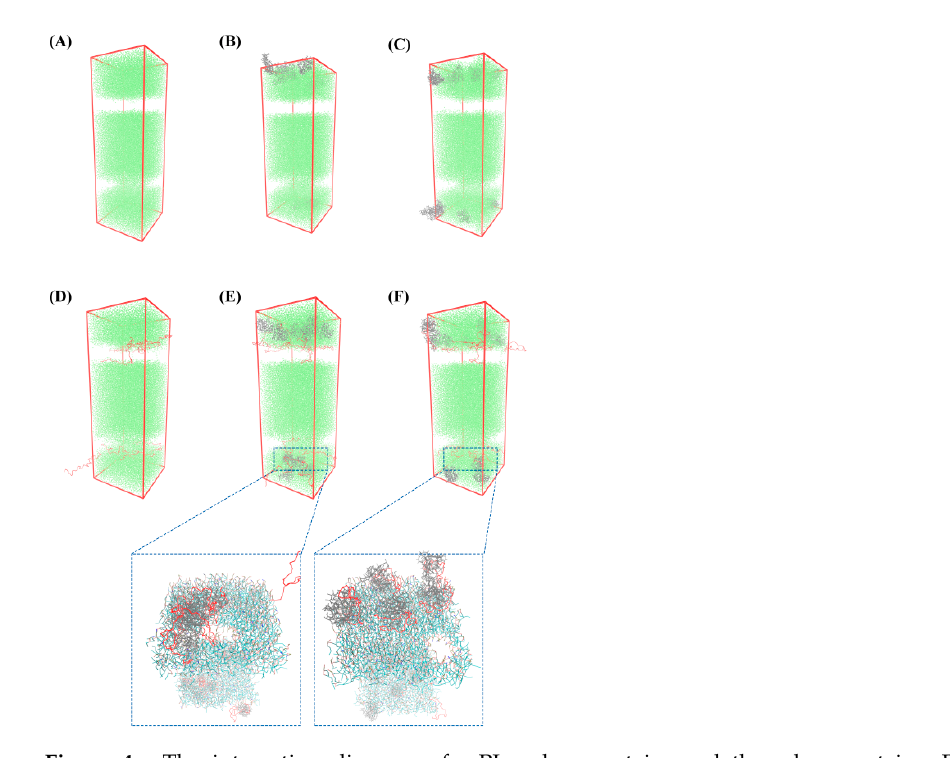
Figure 4. The interaction diagram of ε -PL, whey protein, and the whey protein- ε -PL complexes with the bilayer membrane model of Gram-positive bacteria. ( A ) POPE/POPG. ( B ) α -La-POPE/POPG. ( C ) β -Lg-POPE/POPG. ( D ) ε -PL-POPE/POPG. ( E ) ε -PL- α -La-POPE/POPG. ( F ) ε -PL- β -Lg-POPE/POPG.